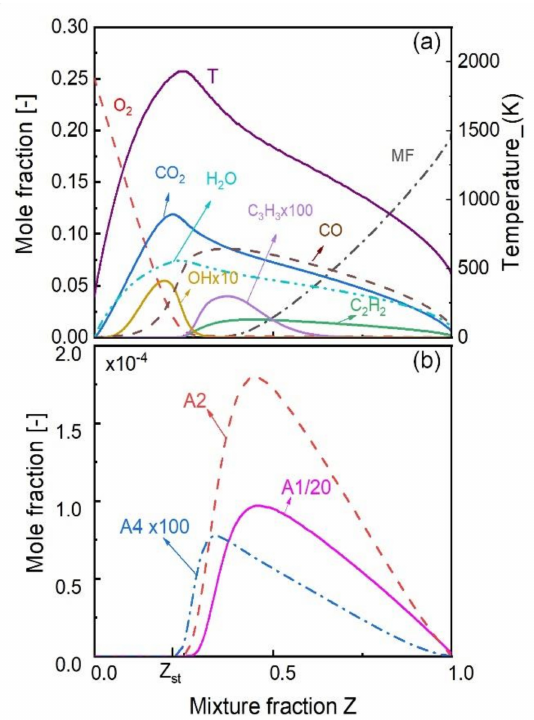
Figure 3. Computed flame structure of the ( a ) temperature profile, concentration of major species, and ( b ) PAHs in the mixture fraction space.